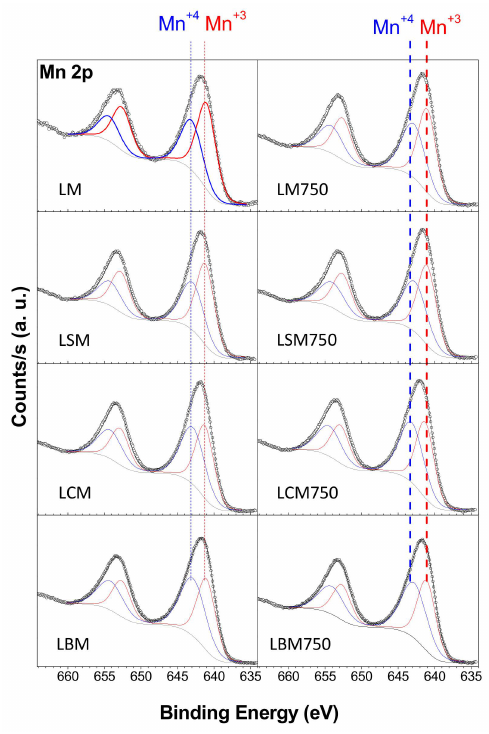
Figure 9. Mn 2p XPS spectra (dots) for all as-prepared and calcined samples fitted with two chemical states named Mn 4+ (blue lines) and Mn 3+ (red